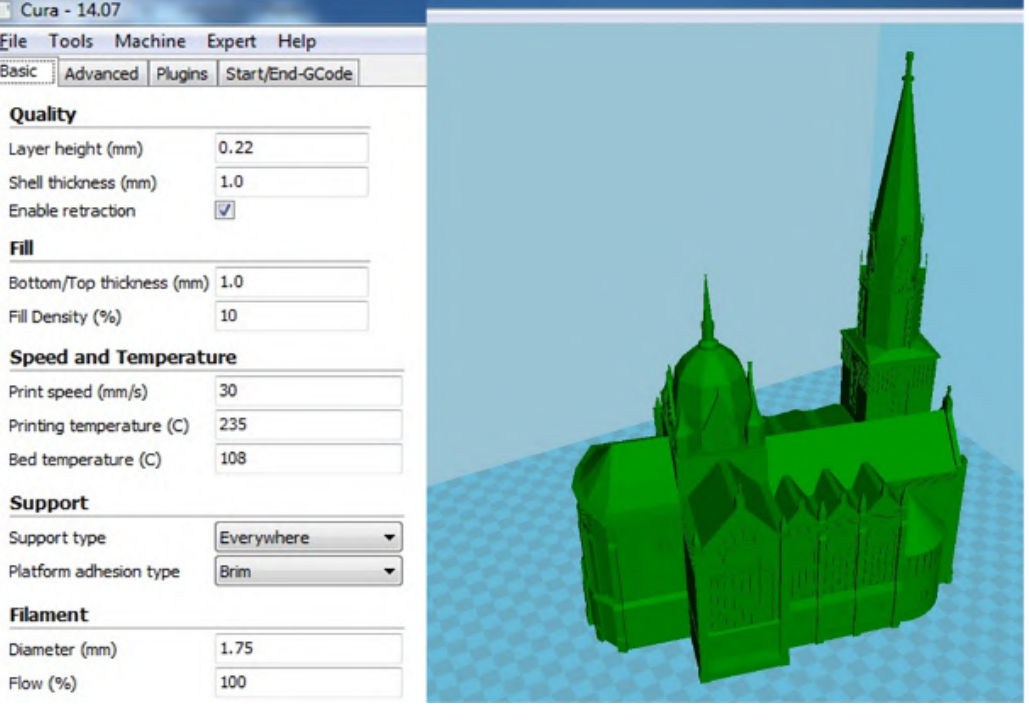
Figure 72: Presentation of paper